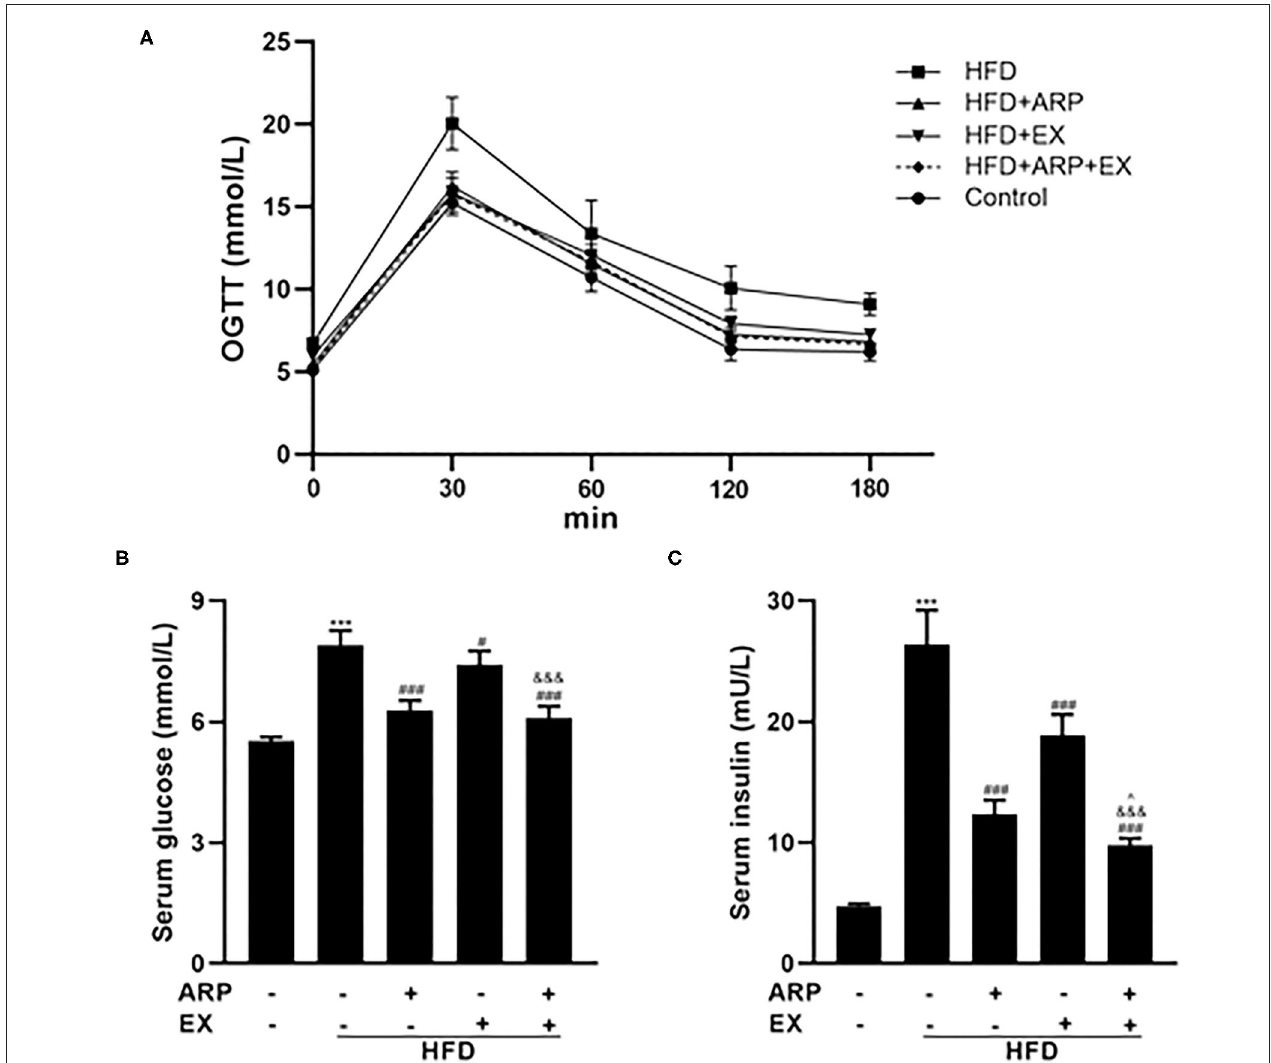
FIGURE 2 | Effects of ARP and EX on insulin sensitivity in HFD-fed mice. (A) Blood glucose tolerance, (B) serum glucose, (C) serum insulin in C57BL/6 mice feeding HFD. All the values are exhibited as the mean ± SME, n = 8. *** p < 0.001 vs. related control group. # p < 0.05 and ### p < 0.001 vs. related HFD group; ∧ p < 0.05 vs. related HFD + AR group; &&& p < 0.001 vs. related HFD + EX